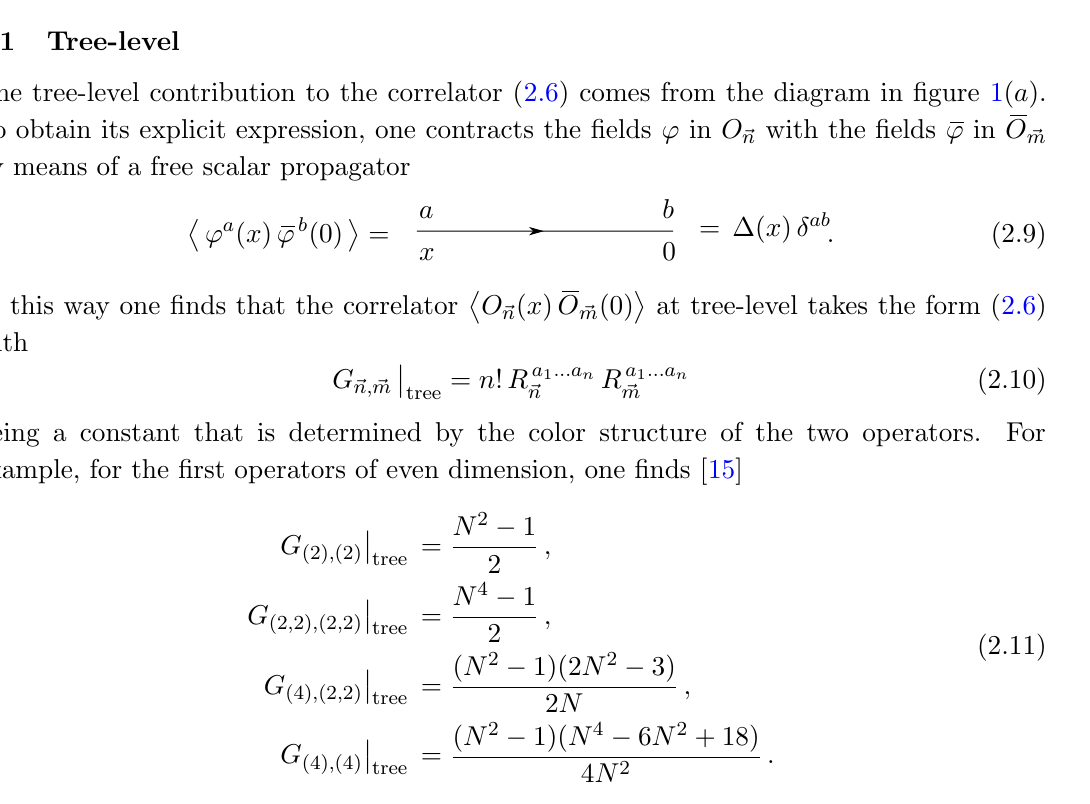
Figure 2 . The vanishing of the one-loop propagators of the three adjoint scalars (cid:8) I in the theory. The wavy line corresponds to the vector super(cid:12)eld. In the second diagram, the three-point vertices are proportional to the totally anti-symmetric tensor (cid:15) IJK